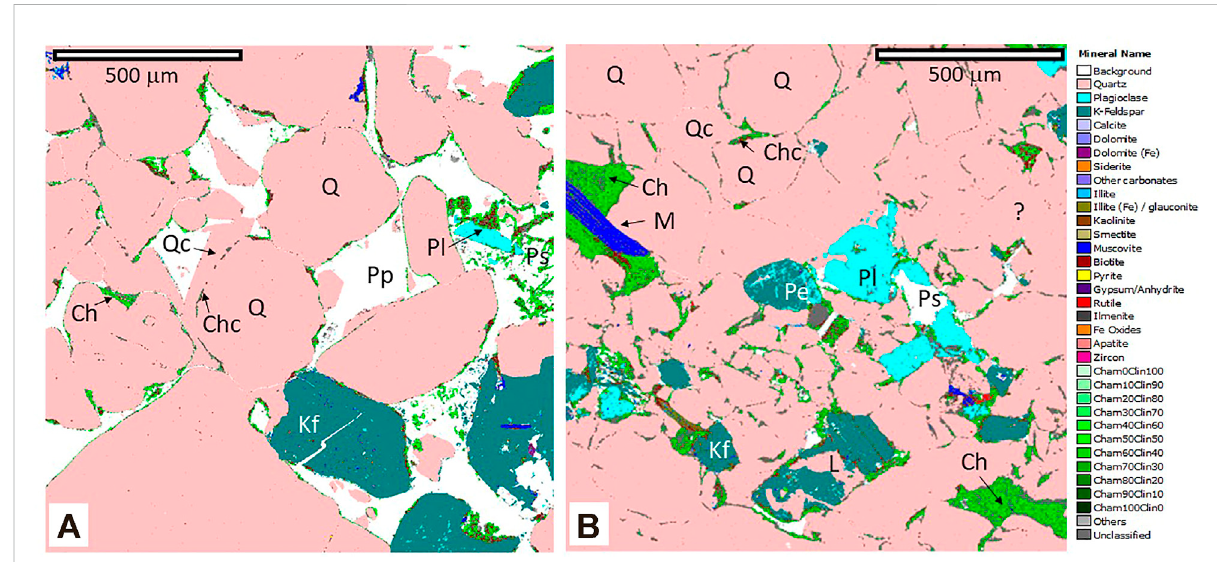
FIGURE 3 Detrital quartz-dominated Lower Jurassic deltaic sandstones from Halten Terrace, Norway, with minor feldspars (mineral colour index on the right hand side). (A) Patchy chlorite coats (Chc) have developed on detrital quartz (Q), K-feldspar (Kf) and plagioclase (PL) grains, leaving about 20% primary porosity (Pp). Quartz (Qc) has grown where there weregaps in thegrain coat. Quartz cementcan only bediscerned from quartz grainsby (i) the presence of the grain coat and (ii) the euhedral termination of the cement into the open pore. (B) Chlorite coats (Chc) are less well developed than (A) , allowing extensive quartz cement and leaving only about 2% primary porosity but some secondary porosity (Ps) is also present. Quartzcementisgenerally hardtodifferentiatefrom quartzgrains, leaving areasofthesectioncontainingquartz ofunknown origin (e.g., markedby “ ? ” ). This sample contains muscovite fl akes (M) and patchesof pore fi lling chlorite (Ch). (Legend) The colour schemefor all SEM-EDS images (Figures 3 – 14) is added to this fi gure. The approach used in most images follows the method developed by Worden et al. (2018c) to identify eleven types of